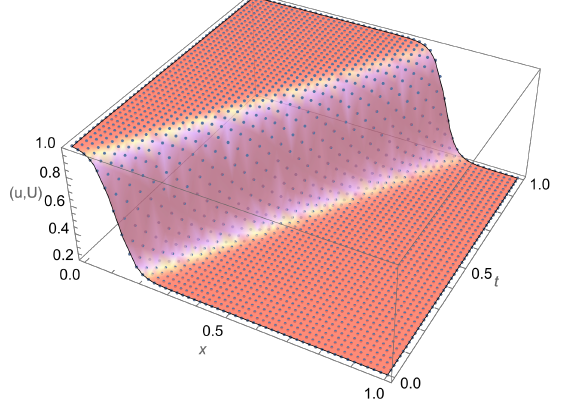
Figure 4. 3D plot: N = NT = 50.